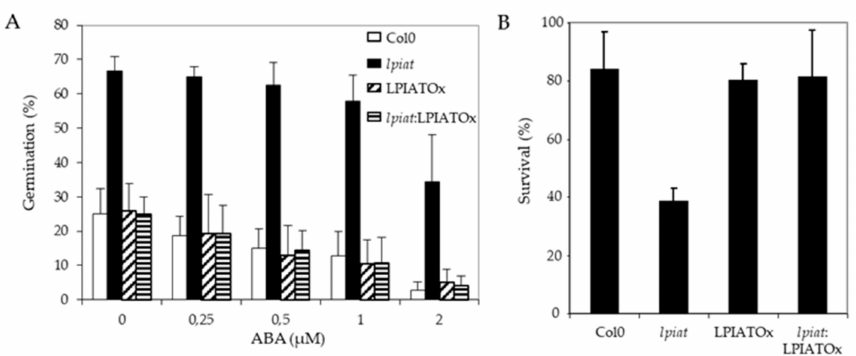
Figure 7. ABA-related modifications in seed germination and drought stress resistance in LPIAT mutants. ( A ), Germination rate from wild-type and the indicated LPIAT mutant seeds. Seeds were germinated for 29 h on 1 / 2 MS medium, 0.8% agar and 1% Sucrose. The medium was supplemented with various ABA concentrations. Values are means ± SD of 4 independent experiments. ( B ), E ff ect of a drought stress on survival rate of the di ff erent LPIAT mutants grown on a medium supplemented with ABA before the stress. Seeds were sown on filter laying on 1 MS medium, 0.8% agar and 2